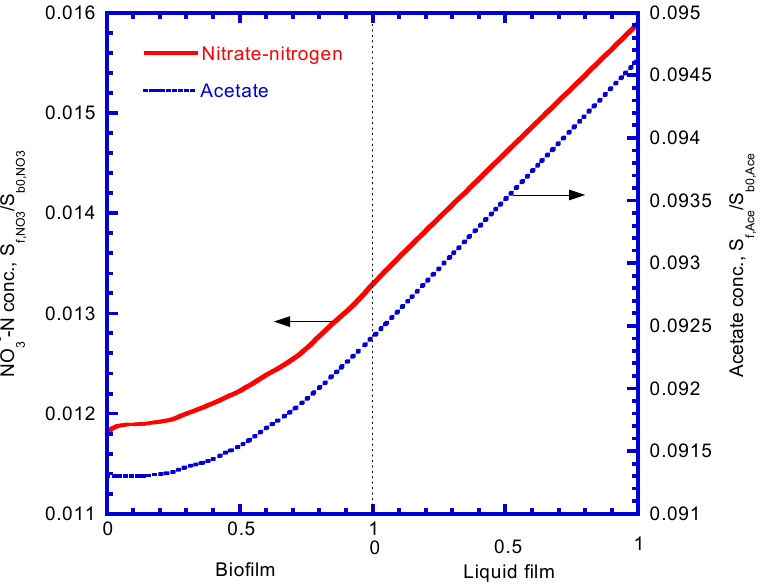
Figure 9. Concentration profiles of nitrate and acetate in the liquid film and biofilm.